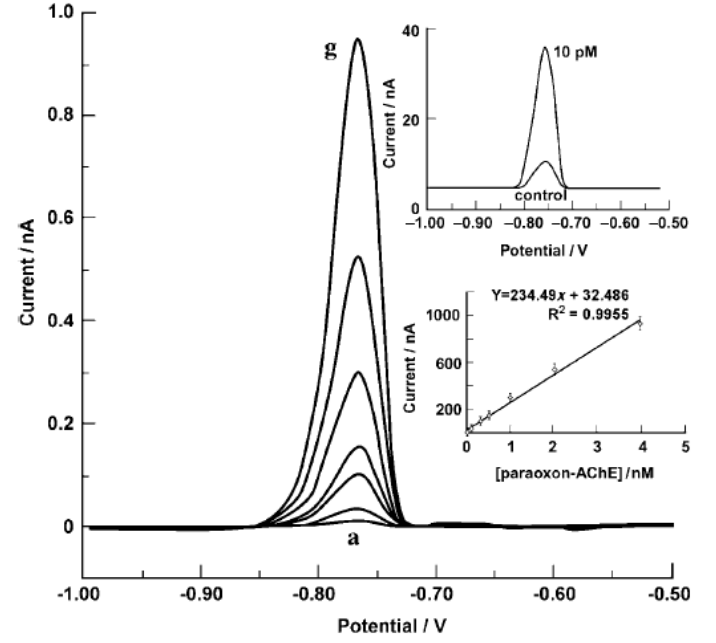
Figure 5. Typical electrochemical responses of the immunosensor with the increasing phosphorylated AChE concentration (0.01, 0.05, 0.3, 0.5, 1.0, 2.0, 4 nm from a to g). The insets show the resulting calibration plot (bottom) and the electrochemical responses of 10 pM and 0 pM (top) paraoxon-AChE. Each concentration was measured three times with three different immunosensors